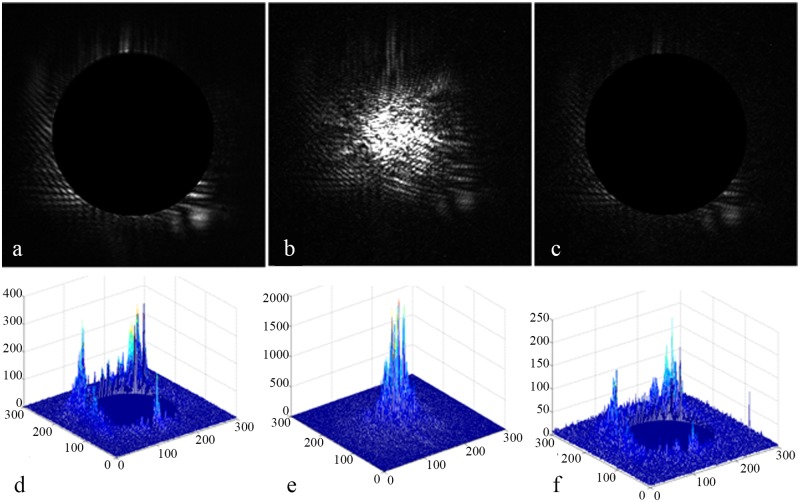
The best matching point for the center of the schlieren ball in the main lobe image.(a) The cutpb image. (b) The cutzb image. (c) The best matching with the schlieren ball dug from the main lobe image. (d) Three-dimensional cutpb image. (e) Three-dimensional cutzb image. (f) Three-dimensional image of the best matching with the schlieren ball dug from the main lobe image.